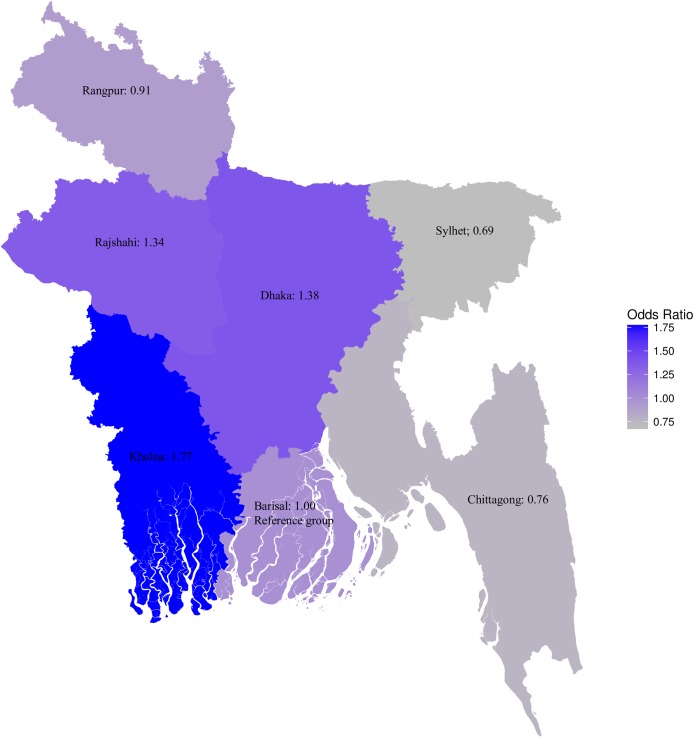
Likelihood of caesarean delivery by region.